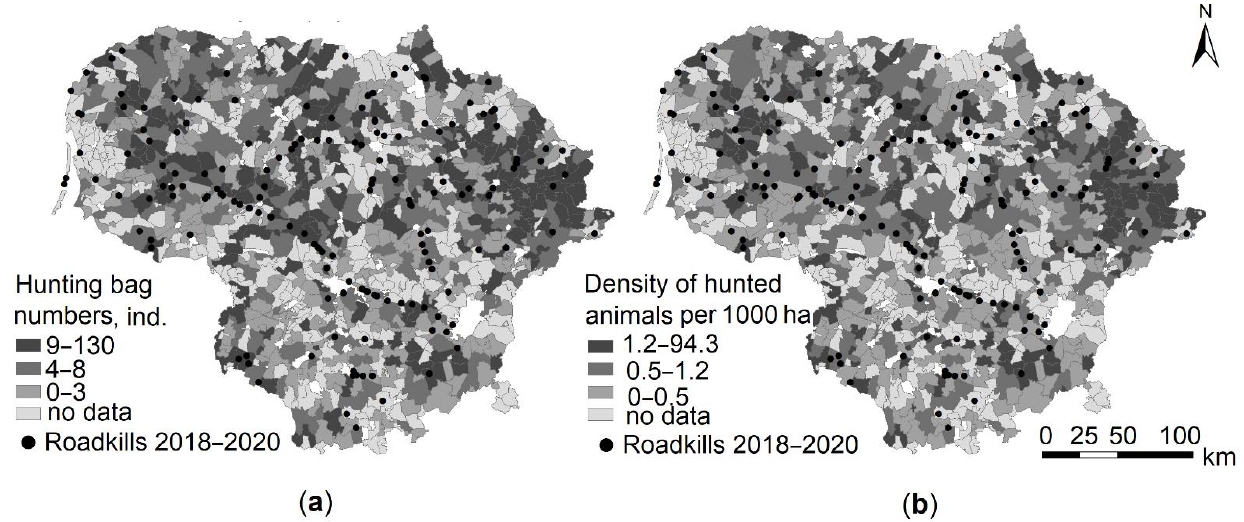
Figure 5. Spatial distribution of raccoon dog hunting bag numbers ( a ) and density of hunted animals ( b ) compared to roadkills at the local level in 2018 – 2020. White colour denotes territories of towns and cities, excluded from the hunting areas.